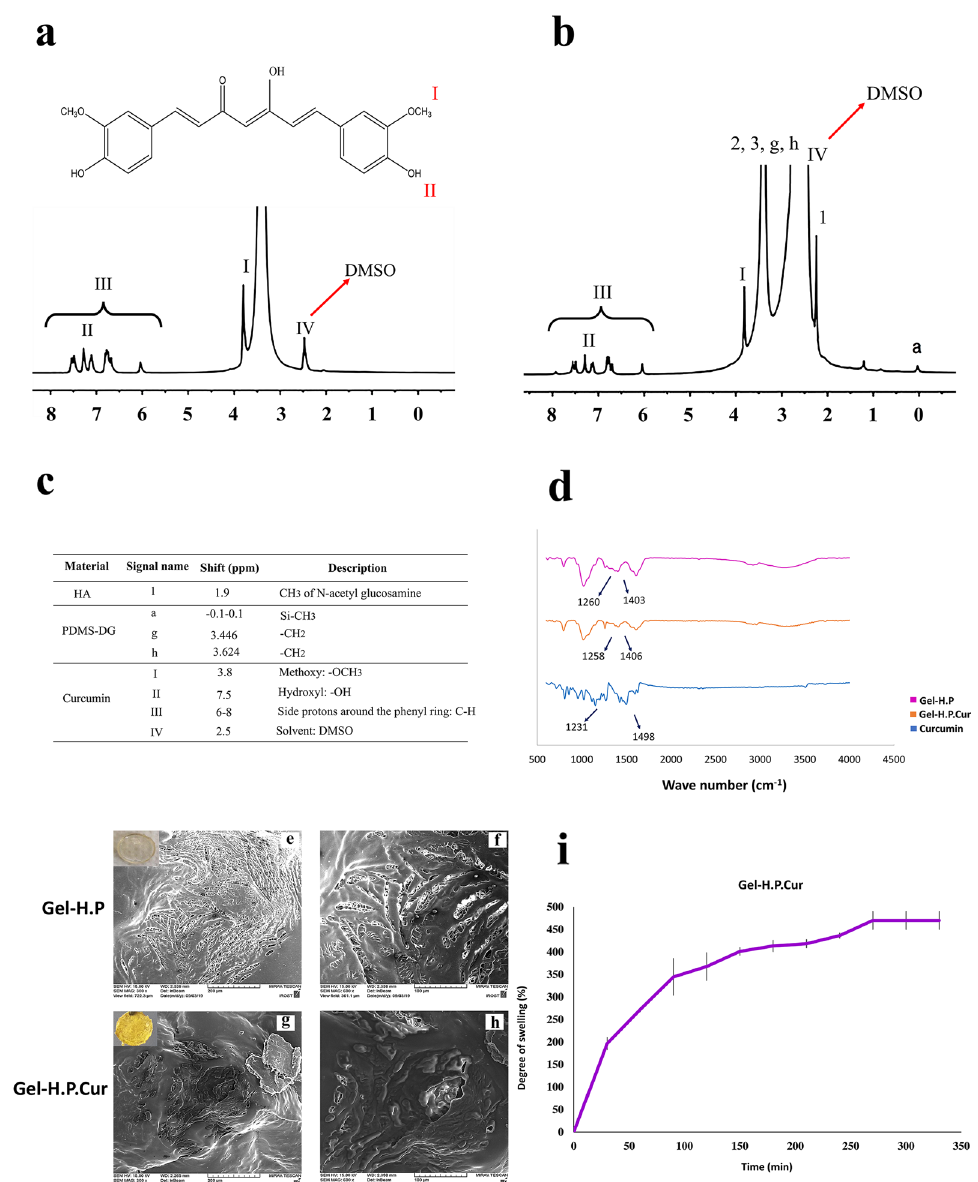
Fig. 2 Hydrogels characterization using NMR, FTIR, SEM and swelling assay. a 1 H NMR spectrum of the pure curcumin in DMSO with specific peaks for the methoxy group (I), hydroxyl group (II) and other protons around the phenyl ring (II). b 1 H NMR spectrum of the curcumin released from Gel-H.P.Cur with specific peaks of pure curcumin (I, II, III). Traces of hyaluronic acid (1: CH 3 of N-acetyl glucosamine and 2, 3: protons around the sugar ring) and PDMS (a: Si-CH 3 : and g, h: CH 2 ) were detected in the spectrum. The red numbers in the chemical structure represented the chemical groups detected by NMR. c NMR characteristic peaks of pure curcumin and the curcumin released from Gel-H.P.Cur. d FTIR spectra of Gel-H.P, Gel-H.P.Cur, and Curcumin. Characteristic peaks of HA (~ 1400 cm − 1 related to carboxylic acid: O–H bend), PDMS-DG (~ 1260 cm − 1 related to Si–C) and curcumin (1231 cm − 1 : phenolic C–O group and 1498 cm − 1 : aromatic C O band stretching vibration) were detected. e – h SEM micrographs of = the hydrogels: e and f are micrographs for Gel-H.P, and g and h are for Gel-H.P.Cur. Imaging was performed after coating the lyophilized hydrogels with gold. The detail of magnification and scale bars are demonstrated under each image. i Assessment of the swelling rate of the Gel-H.P.Cur in distilled water at 37 °C. Gel-H.P.Cur showed a high level of water